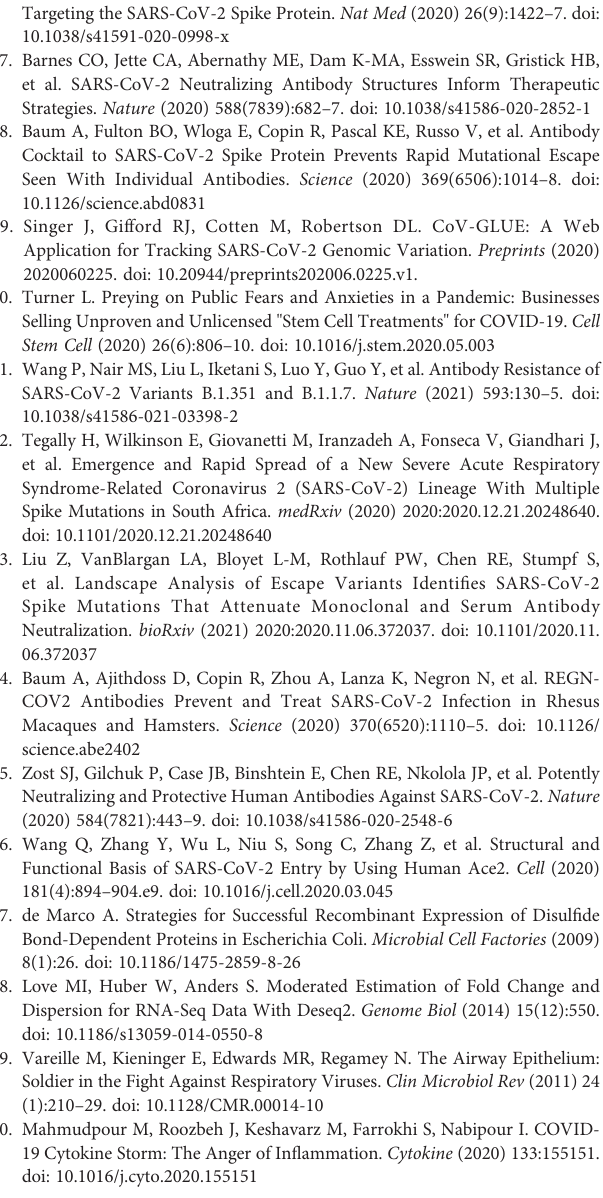
differentially expressed genes modulated in SARS-CoV-2 infected HBECs, compared with non-infected HBECs. Supplementary Figure 5 | Host responses in SARS-CoV-2 – infected HBECs in the presence and absence of anti-RBD pAbs. (A) Top 20 enriched relevant diseases and functions modulated in HBECs in response to SARS-CoV-2 infection in the presence and absence of anti-RBD pAbs ( p -value < 0.05); – log( P -values) are plotted on the x -axis. (B) Summary of enriched pathways following SARS-CoV-2 infection with or without anti-RBD pAb treatment. Supplementary Figure 6 | Gene ontology and pathway patterns for host responses in SARS-CoV-2 – infected HBECs in the presence and absence of anti- RBD pAbs. (A) Top enriched ontology clusters following SARS-CoV-2 infection in the presence and absence of anti-RBD pAbs. (B) Airway pathology – related differentially expressed genes modulated in SARS-CoV-2 – infected HBECs combined with anti-RBD pAbs